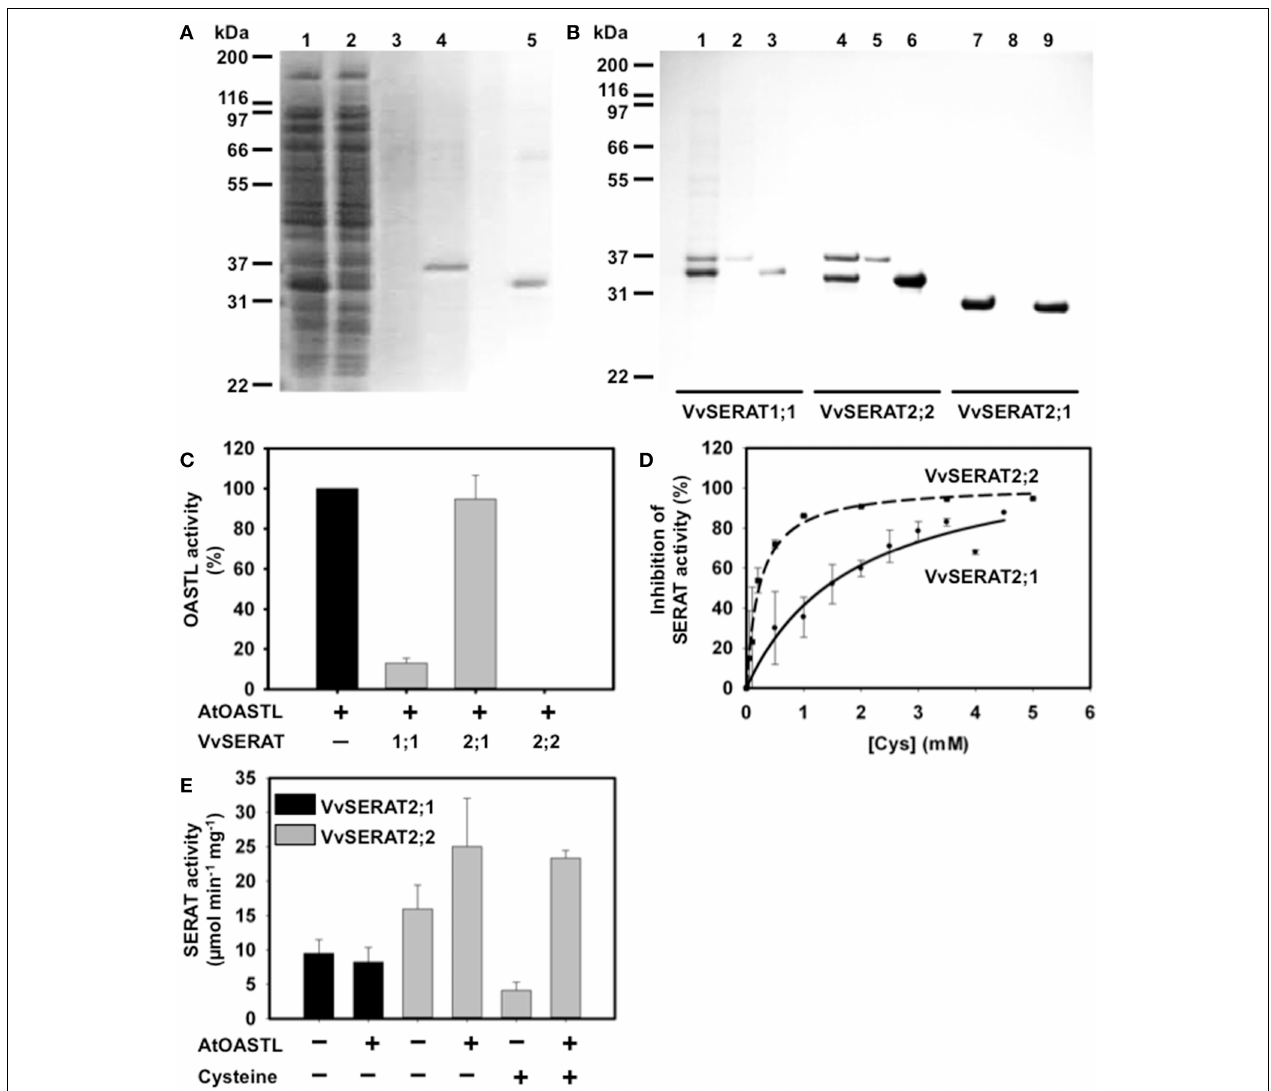
FIGURE 3 | Biochemical characterization of the SERAT protein family of grapevine. (A) Purification of recombinant VvSERAT2;2 in fusion with a N-terminal His tag and immobilized in a metal affinity of column. SDS-PAGE gel stained with Coomassie blue. 1, E. coli crude proteins after expression of VvSERAT2;2 protein; 2, flow through after the contact with Ni affinity column; 3, washing steps with extraction buffer containing 10mM OAS and 80mM imidazole; 4, elution of AtOASTL-B with extraction buffer containing 400mM imidazole; 5, elution of VvSERAT2;2 with extraction buffer containing 400mM imidazole. (B) Interaction between AtOASTL-B and VvSERAT and the formation of the cysteine synthase complex (CSC). SDS-PAGE gel stained with Coomassie blue. Elution from the Ni affinity column: 1, 4, 7—CSC elution with extraction buffer supplemented with 10mM OAS; 2, 5,